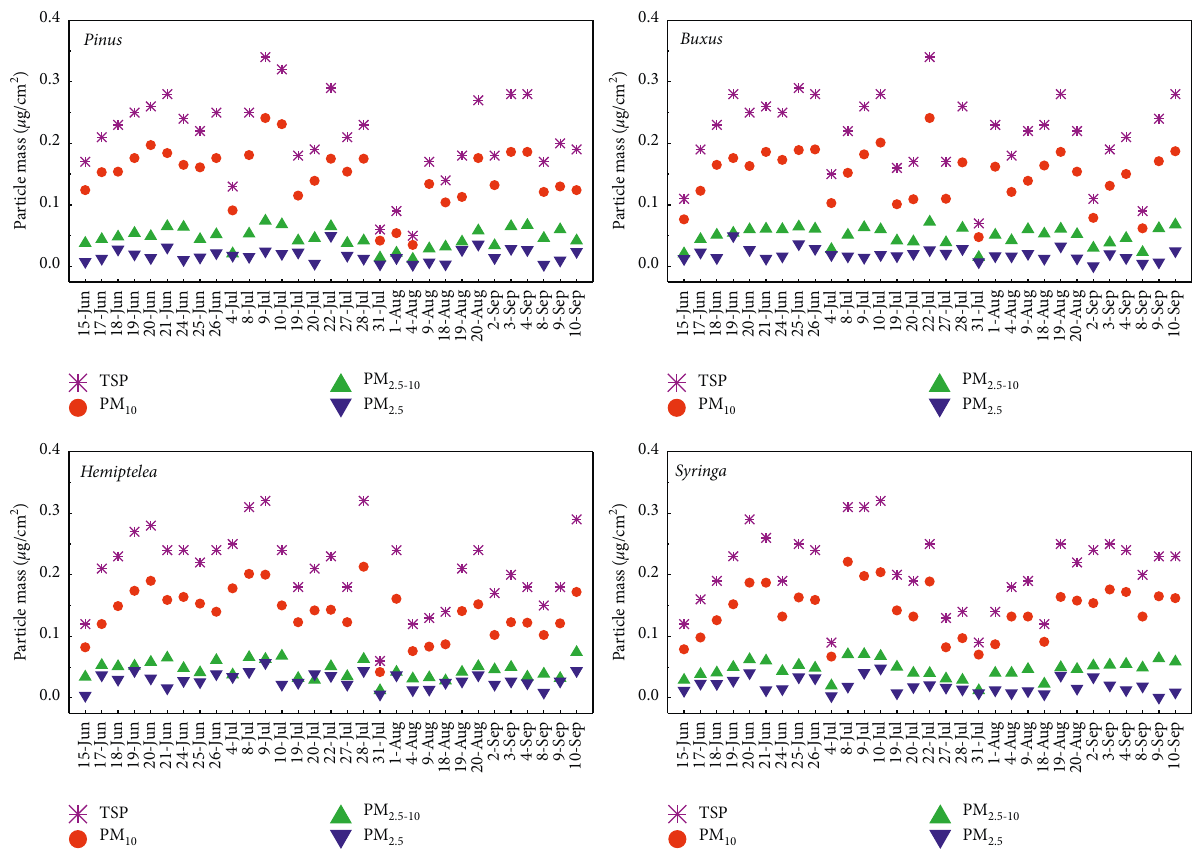
Figure 2: The amount of particles per unit area of different leaves in the dew deposition